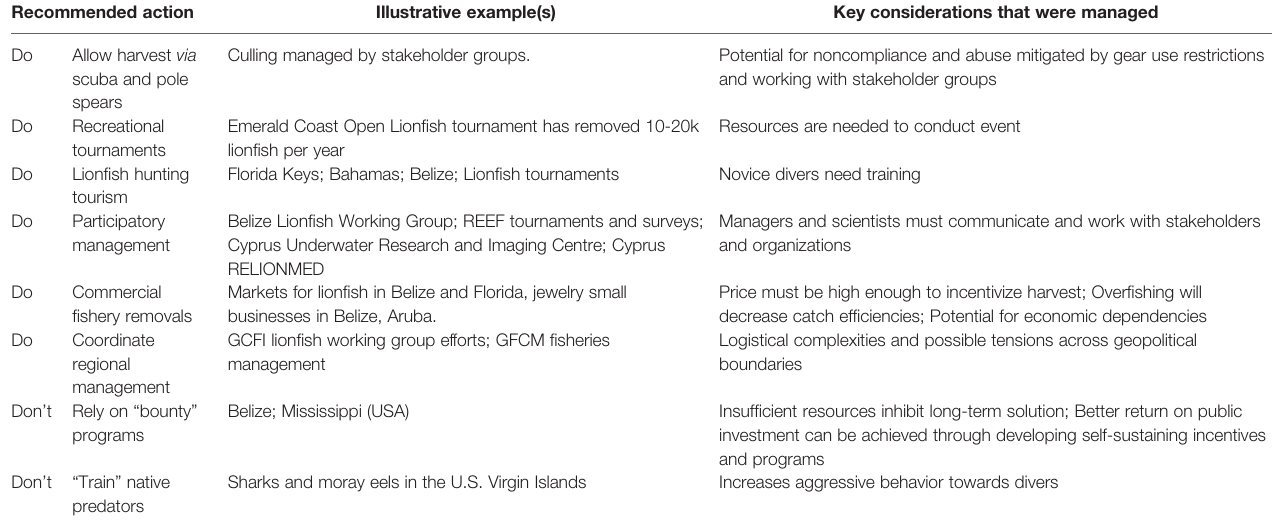
TABLE 1 | A summary of recommended actions for lion fi sh control in the Mediterranean Sea using examples and key considerations from management in the Western Atlantic Ocean. Recommended